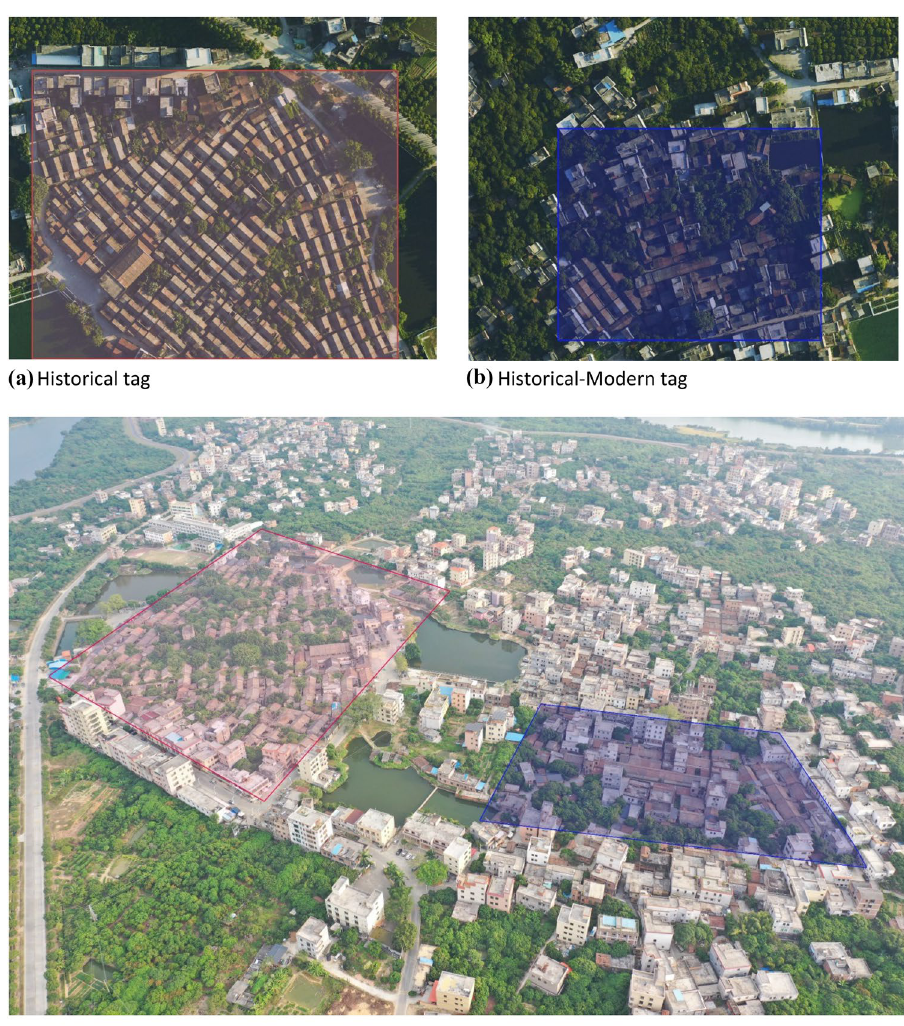
Fig. 10 Example images for the object detection task